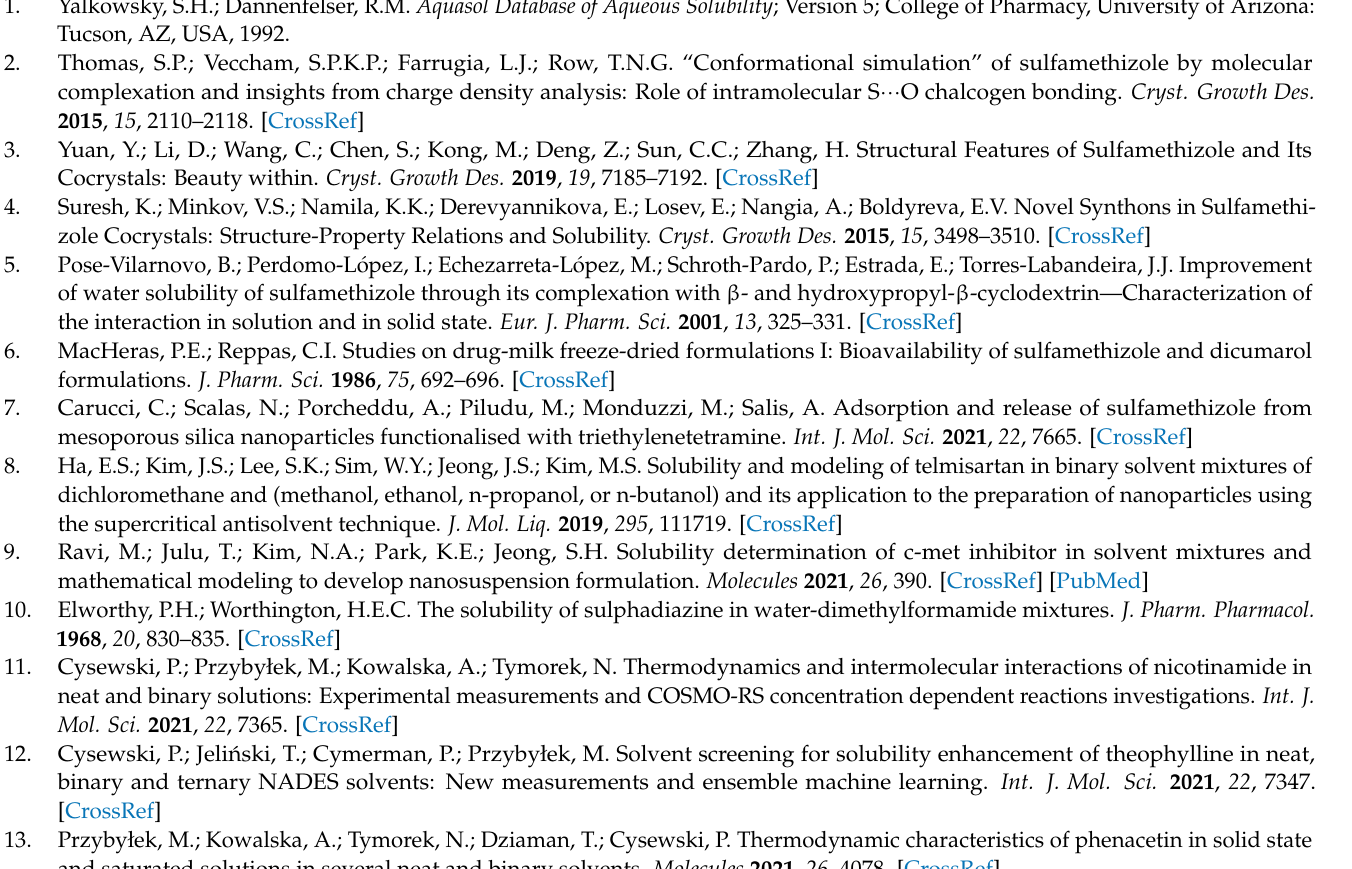
Figure S8: Distributions of the values of descriptors characterizing SMT in aqueous acetonitrile binary mixtures at room temperature, Figure S9: Distributions of the values of descriptors characterizing SMT in aqueous propylene glycol binary mixtures at room temperature, Table S1: List of SANN included in the ensemble of neural networks (ENN) for Sulfamethizole solubility prediction, Table S2: The environmental impact scores calculated using PARIS III